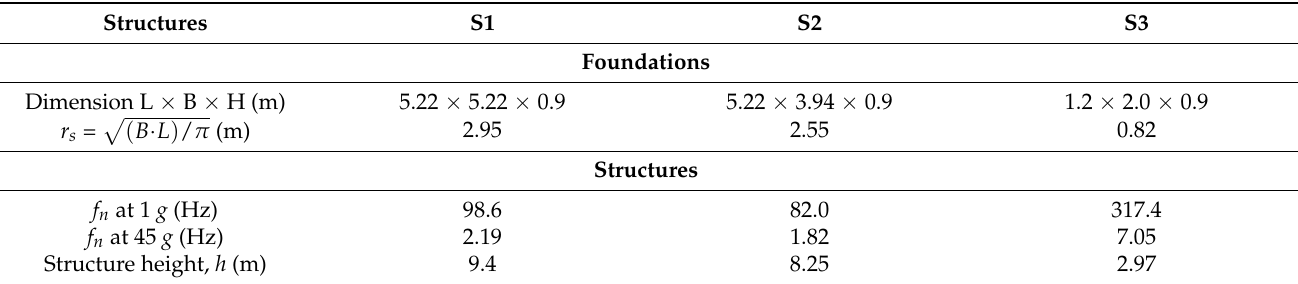
Table 1. Foundations and structures’